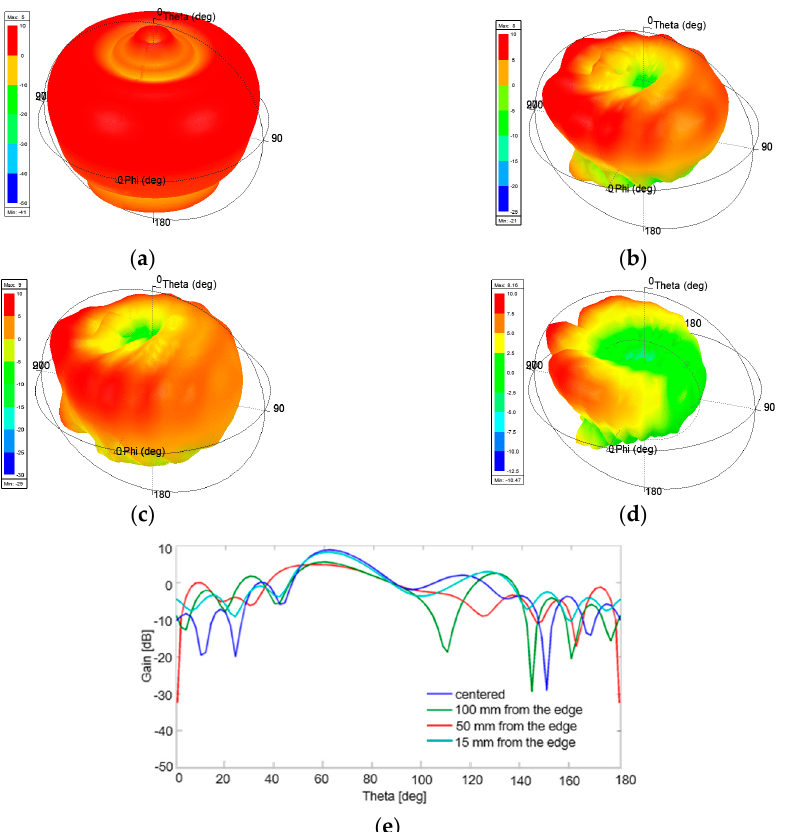
Figure 6. Comparison of antenna radiation pattern between centered and off-centered mounting configurations, ( a ) centered, ( b ) 100 mm, ( c ) 50 mm, ( d ) 15 mm from the right edge, and ( e ) cut of the main beam.